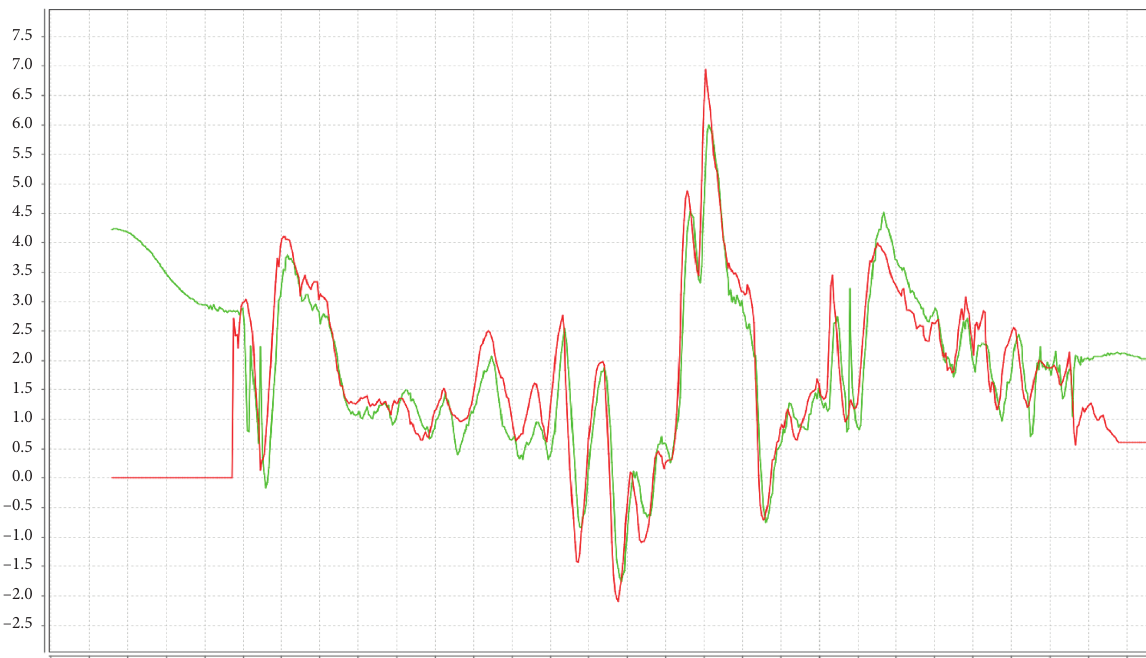
Figure 20: Actual flight pitch angle